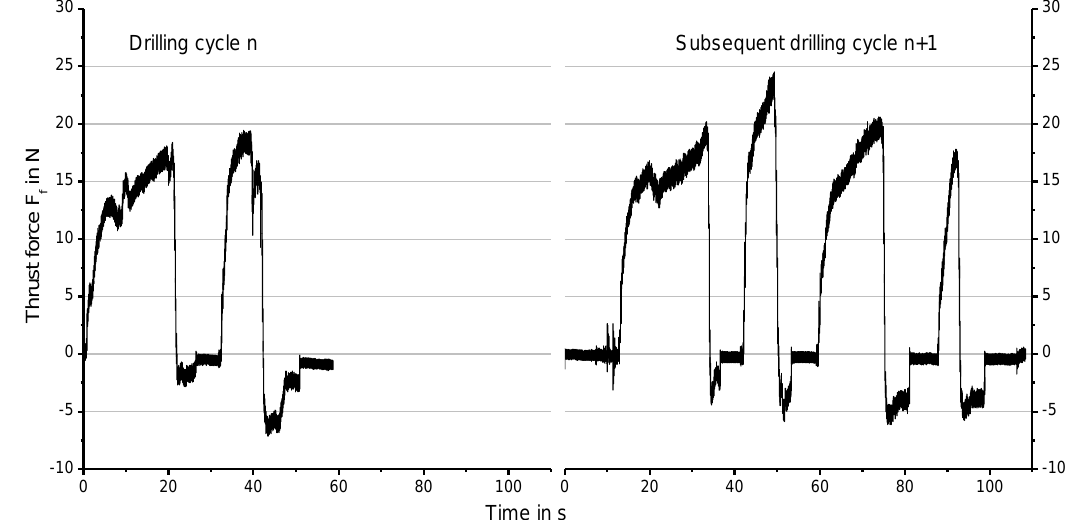
Figure 4. Exemplary signals of the thrust force F f of two subsequent drilling cycles for the same tool (Manufacturer B, Pilot drill).